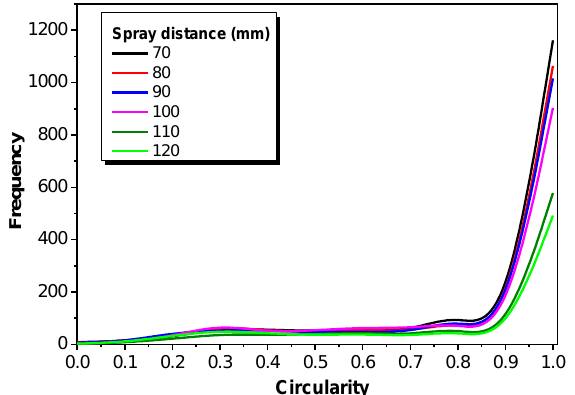
Figure 7. Circularity at different spray distances.